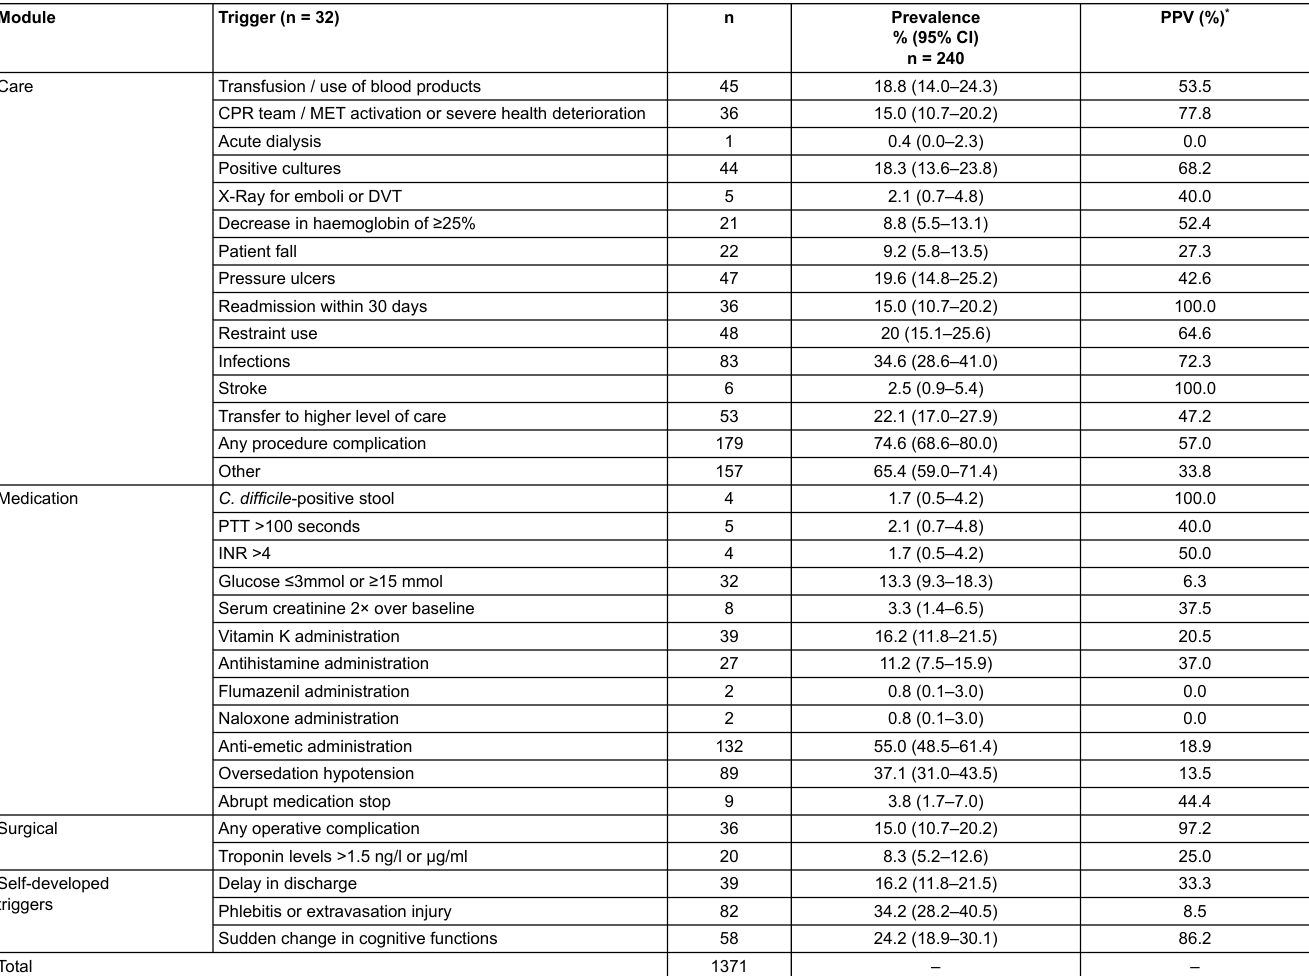
Table 2: Prevalence of triggers during